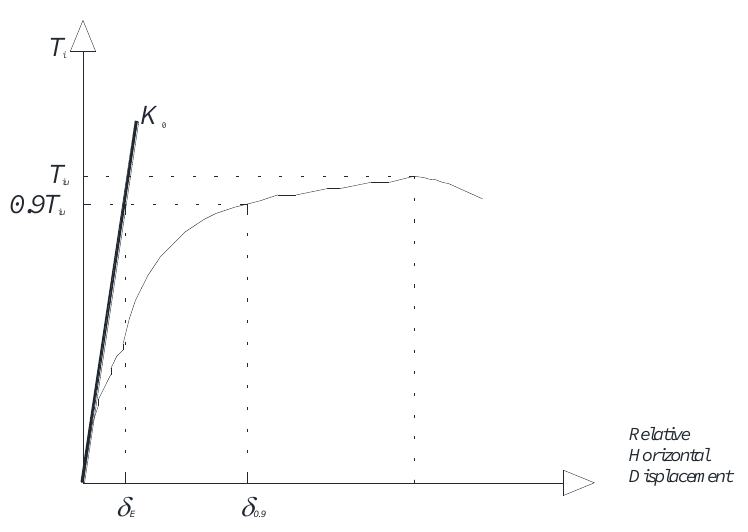
Figure 22. Method used for the calculation of δ E .